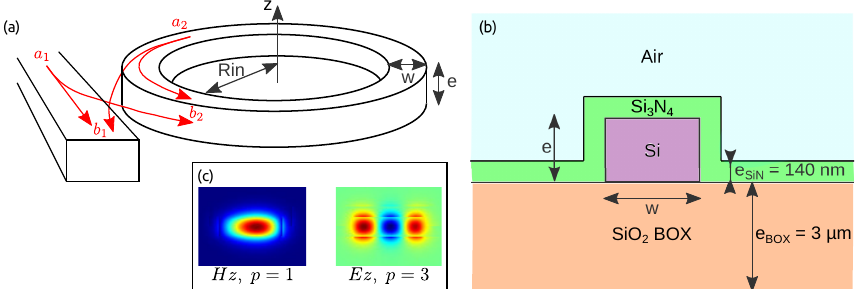
Figure 1. ( a ) System and notation used for the SHG study. ( b ) Cross section of the microring showing the materials and thicknesses. ( c ) Mode profiles of a TE mode with radial number p = 1 and TM mode with radial number p =